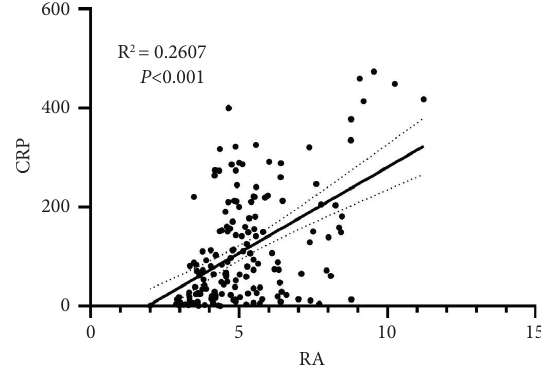
Figure 3: Association between RA and